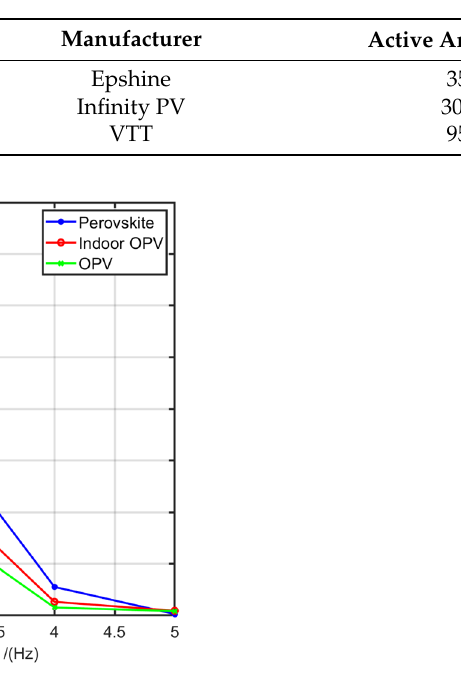
Figure 13. Frequency response of the PE based perovskite and OPV technologies .